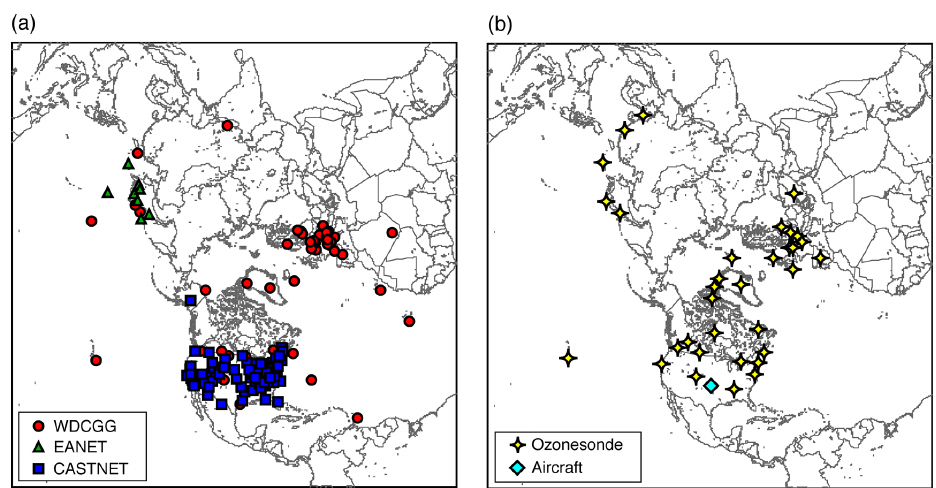
Figure 1. Geographical mapping of the (a) surface and (b) aloft observational sites used in this study. Detailed information about the ozonesonde observation sites is provided in Table